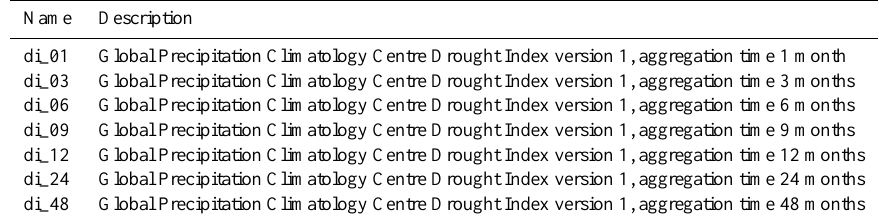
Table 3. Description of the variables used in the netCDF